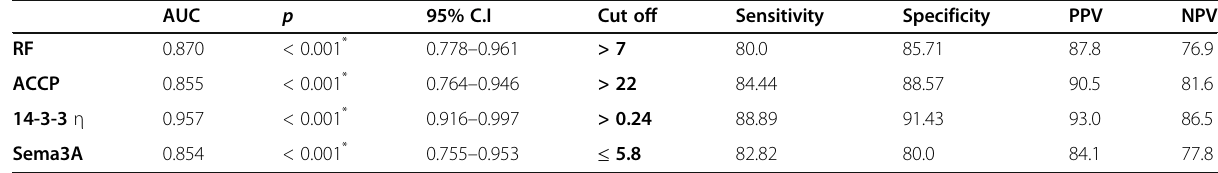
Table 2 Agreement (sensitivity, specificity) for different parameters to predict cases (vs control) AUC p 95% C.I